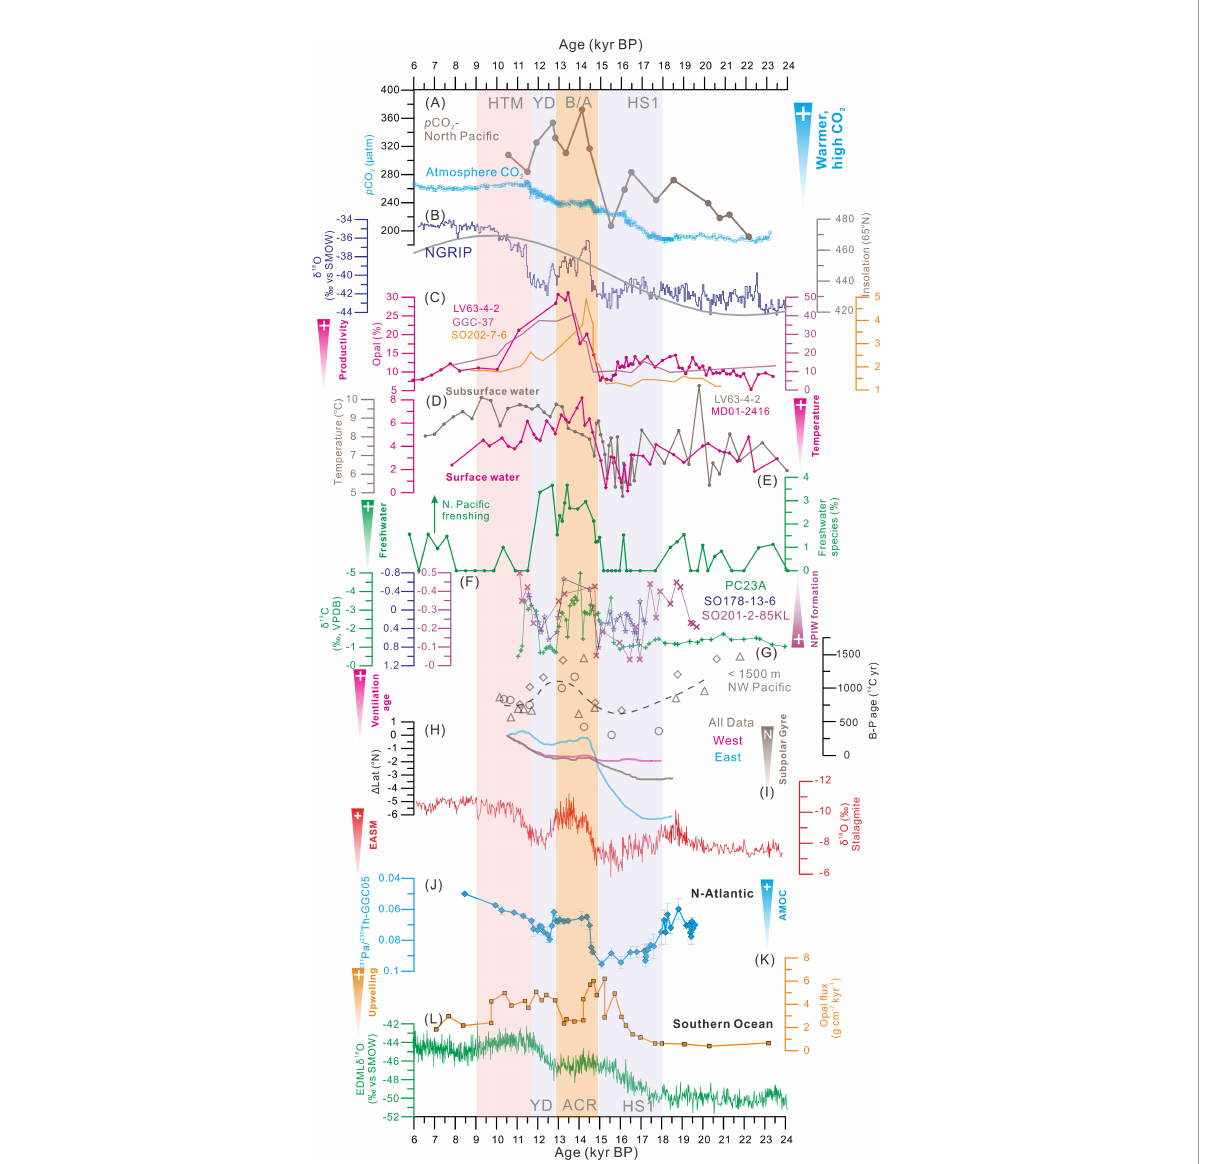
FIGURE 5 Comparison between northern and southern hemispheric processes for the last glacial termination. (A) Atmosphere p CO 2 (Marcott et al., 2014) and the near-surface subpolar North Paci fi c (Gray et al., 2018). (B) d 18 O record of the North Greenland Ice Core Project (NGRIP) ice core (NGRIP Dating Group, 2006) and insolation at 65°N, as references Northern Hemisphere climate signals. (C) Opal content (%) of cores LV63-4-2 (this study), GGC-37 (Keigwin et al., 1992), and SO202-7-6 (Serno et al., 2015). (D) Sea surface temperature (SST) records from cores LV63-4-2 and MD01-2416 (Gebhardt et al., 2008). (E) Freshwater diatom species in core LV63-4-2. (F) d 13 C record of Cibicidoides spp. (versus the Vienna Pee Dee Belemnite) from the intermediate Bering Sea (SO201-2-85KL) and Okhotsk Sea (SO178-13-6; Max et al., 2014). (G) Benthic-planktonic (B-P) 14 C age difference at the intermediate depths (< 1,500 m) in the northwest Paci fi c (NW Paci fi c): core CH84-14 (circles), core GH02-1030 (triangles), and core MR01K03-PC4/PC5 (diamonds; Okazaki et al., 2010). (H) Reconstructed changes in the position of the subpolar gyre boundary (Gray et al., 2020). (I) Chinese speleothem d 18 O record (Cheng et al., 2016). (J) 231 Pa/ 230 Th ratio on the Bermuda Rise (McManus et al., 2004). (K) Opal fl ux records from South Atlantic sediment core TN057-13PC4, showing changes in the upwelling of nutrient-rich deep water (Anderson et al., 2009). (L) d 18 O record of the European Project for Ice Coring in Antarctica (EPICA) Dome C (EPICA Community Members, 2006), as a reference Southern Hemisphere climate signal. Abbreviations: HS1, Heinrich Stadial 1; YD, Younger Dryas Stadial; BA, Bølling-Allerød; N. Paci fi c, North Paci fi c; N-Atlantic, North Atlantic; and ACR, Antarctic Cold